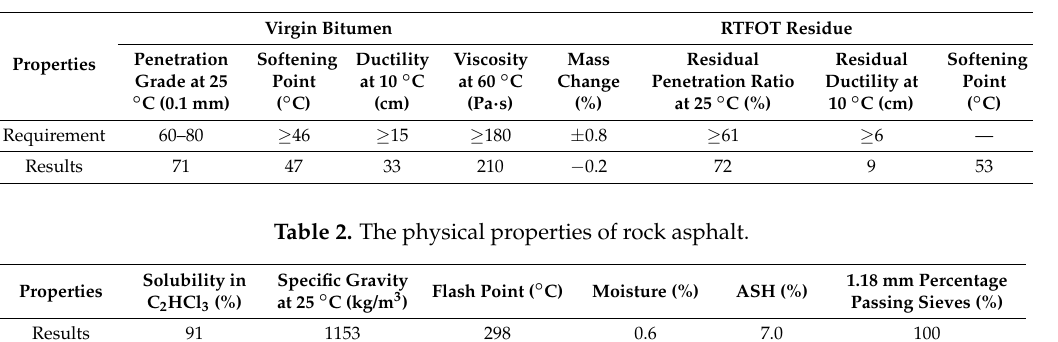
Table 1. The physical properties of petroleum bitumen; RTFOT: Rolling Thin Film Oven Test.